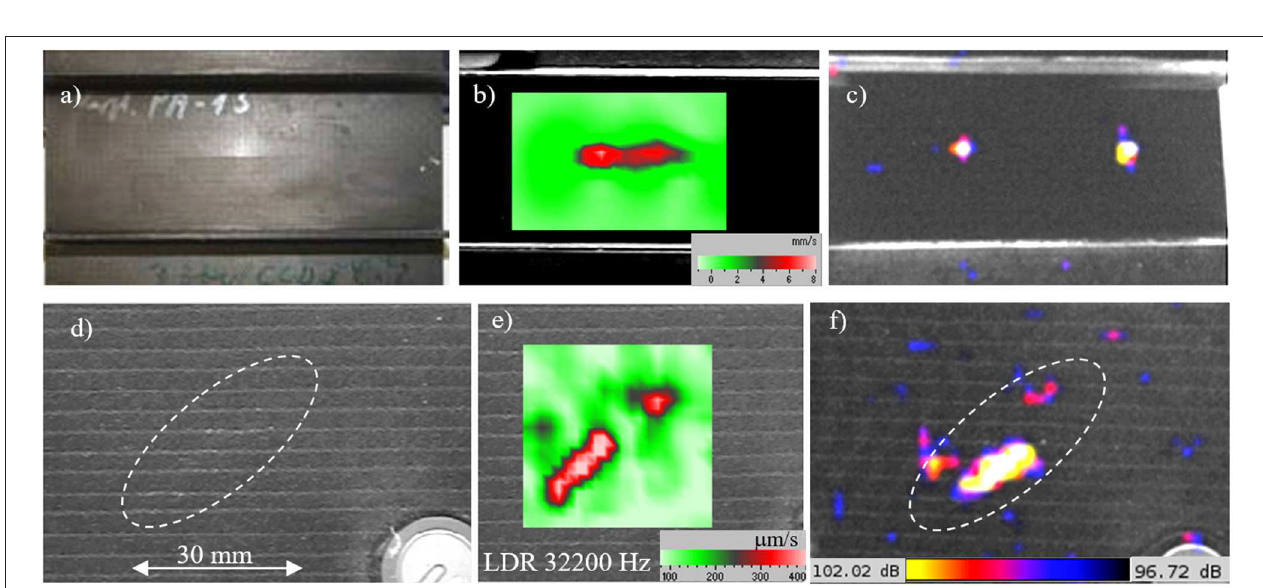
FIGURE 15 | (a) Crack in CFRP stringer-reinforced sample, laser vibrometer LDR image (b) , SoundCam image (c) , 20-J-impact-induced BVID in non-crimp fabric CFRP plate (d) , vibrometry image at fractional LDR frequency 32200Hz (e) , and full-field visualization using acoustic camera (f) .